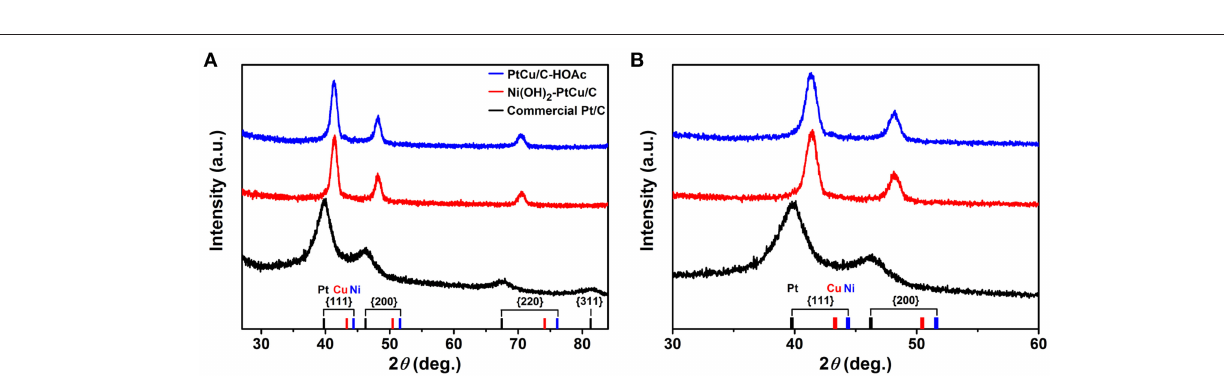
FIGURE 3 | XRD patterns of Ni(OH) 2 -PtCu/C, PtCu/C-HOAc, and commercial Pt/C in (A) wide and (B) narrow 2 θ ranges.